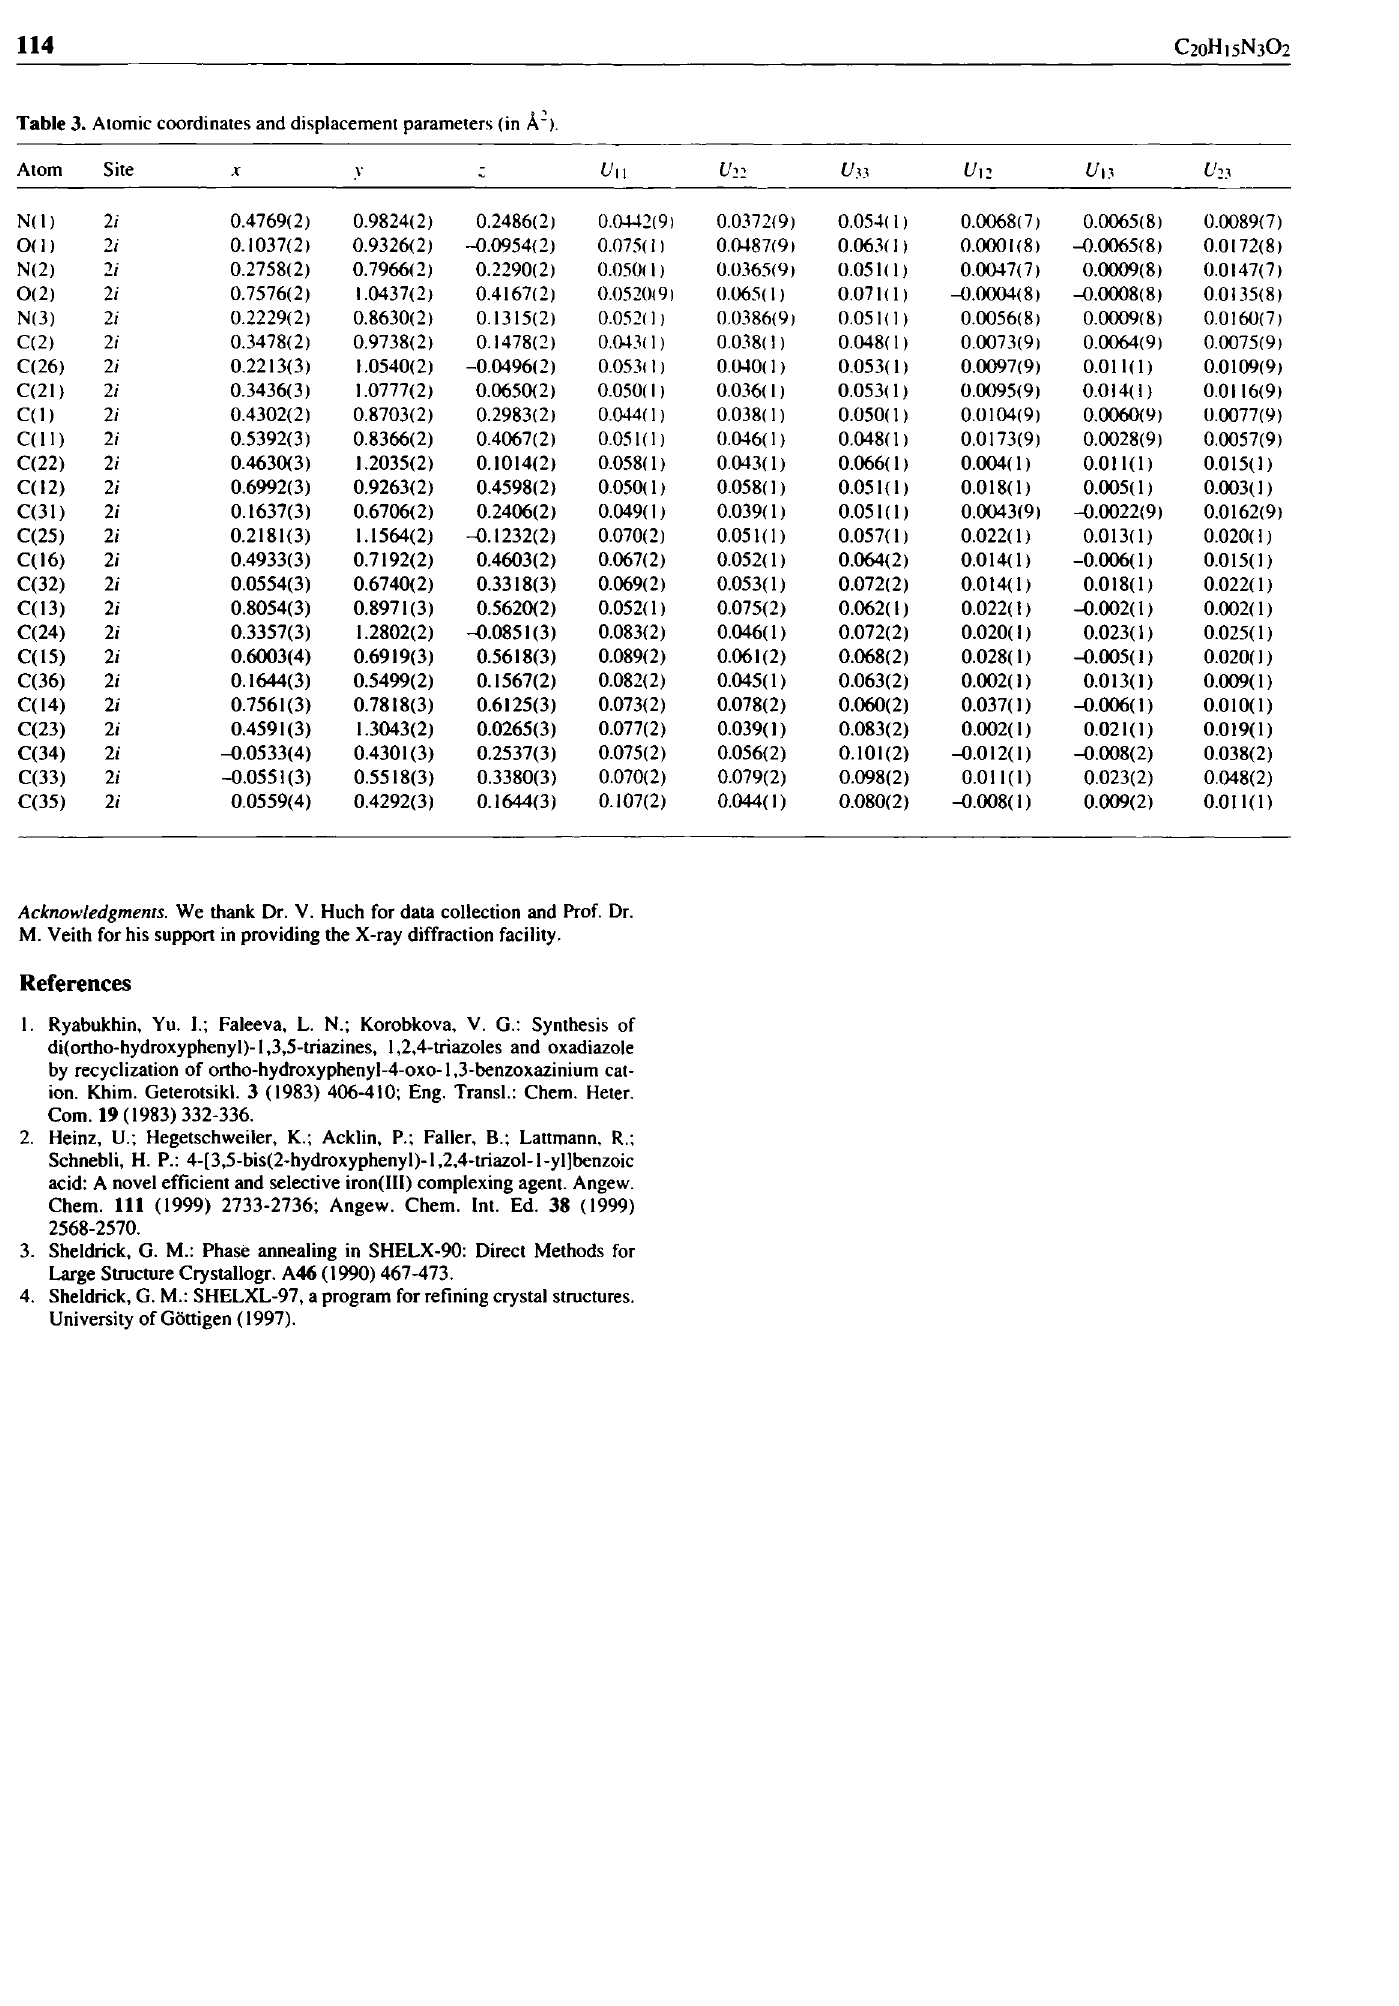
Table 3. Atomic coordinates and displacement parameters (in